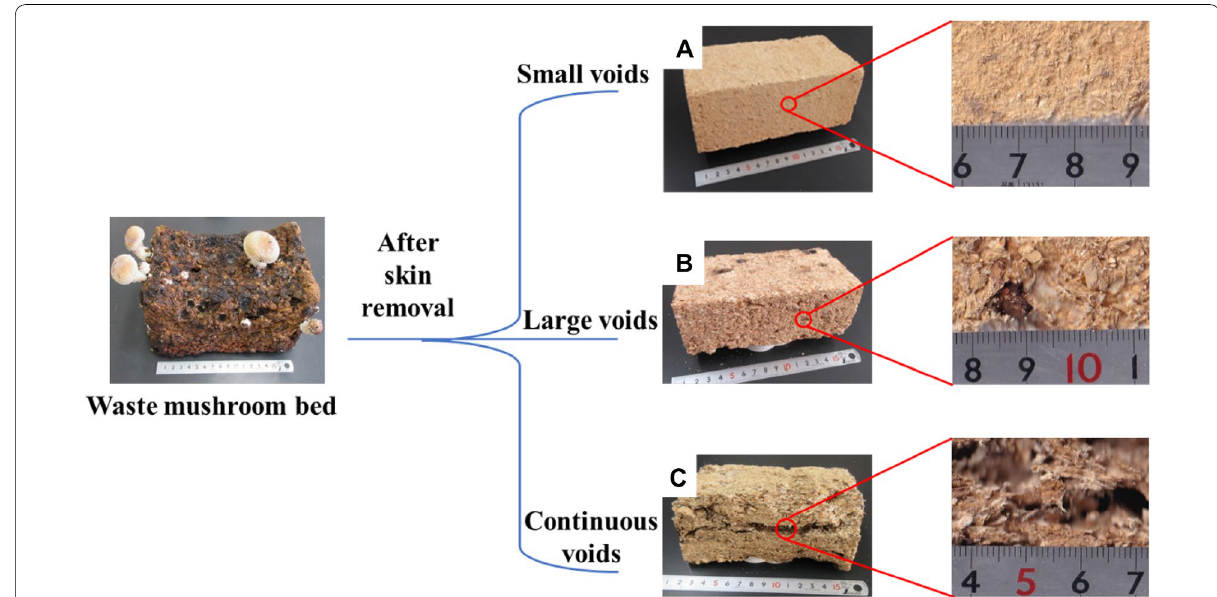
Fig. 1 Three types of voids inside the dried waste mushroom bed. A Small viods, B large viods, C continuous